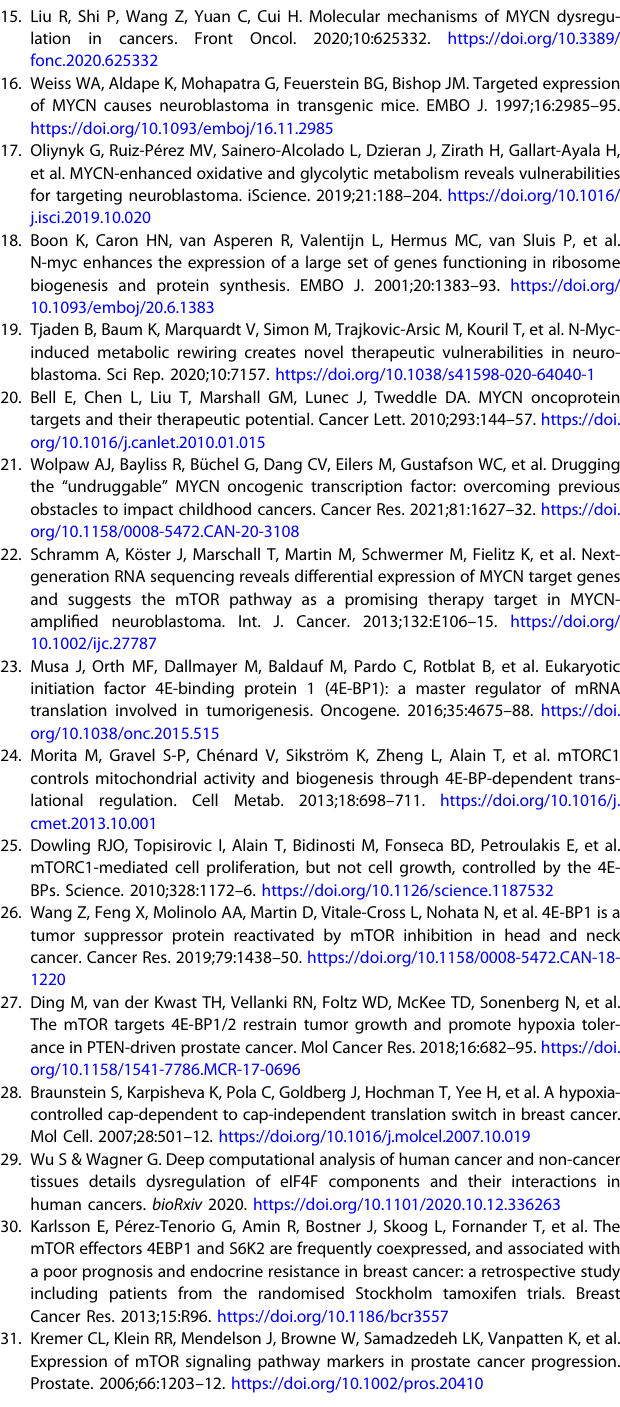
Fig. 5 EIF4EBP1 expression is regulated by MYCN in NB. a , b Relative MYCN and EIF4EBP1 mRNA levels upon siRNA-mediated knockdown of MYCN in the MYCN -ampli fi ed IMR-32 ( a ) and Kelly ( b ) cell lines, as measured by qRT-PCR. c , d SHEP-TR-MYCN cells were treated with doxycycline (1 µg/ml) for the indicated times; EIF4EBP1 mRNA levels were determined by qRT-PCR ( c ) and levels of MYCN and 4EBP1 proteins were monitored by immunoblot using the indicated antibodies ( d ). The different 4EBP1 bands correspond to different phosphorylated forms of 4EBP1. e , f Expression levels of MYCN ( e ) or EIF4EBP1 ( f ) mRNA in SH-SY5Y cells treated with RA for the indicated times (Takeda ’ s dataset, n = 2 for each time point; [60]). Statistics were calculated for each time point compared to the control 0 h time point. g Expression levels of EIF4EBP1 mRNA plotted against expression levels of MYCN mRNA in SH-SY5Y cells treated with RA (Takeda ’ s dataset, n = 2 for each time point; [60]). h Relative EIF4EBP1 mRNA expression in healthy control tissues (ganglia, n = 9) and NB tumors ( n = 26) of a TH-MYCN transgenic mouse model of NB (Balamuth ’ s dataset; [47]). Data were retrieved from the R2: Genomics Analysis and Visualization Platform. Statistics were determined using Student ’ s t test or Mann – Whitney U -test. Exact p -values are presented. * P < 0.05, ** P < 0.01, *** P < 0.001, **** P <